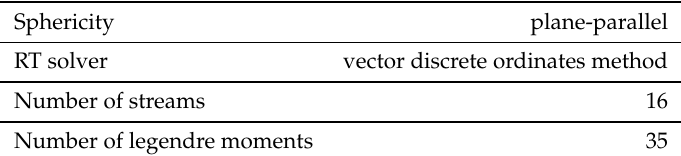
Table A1. General parameters of radiative transfer (RT) calculations.